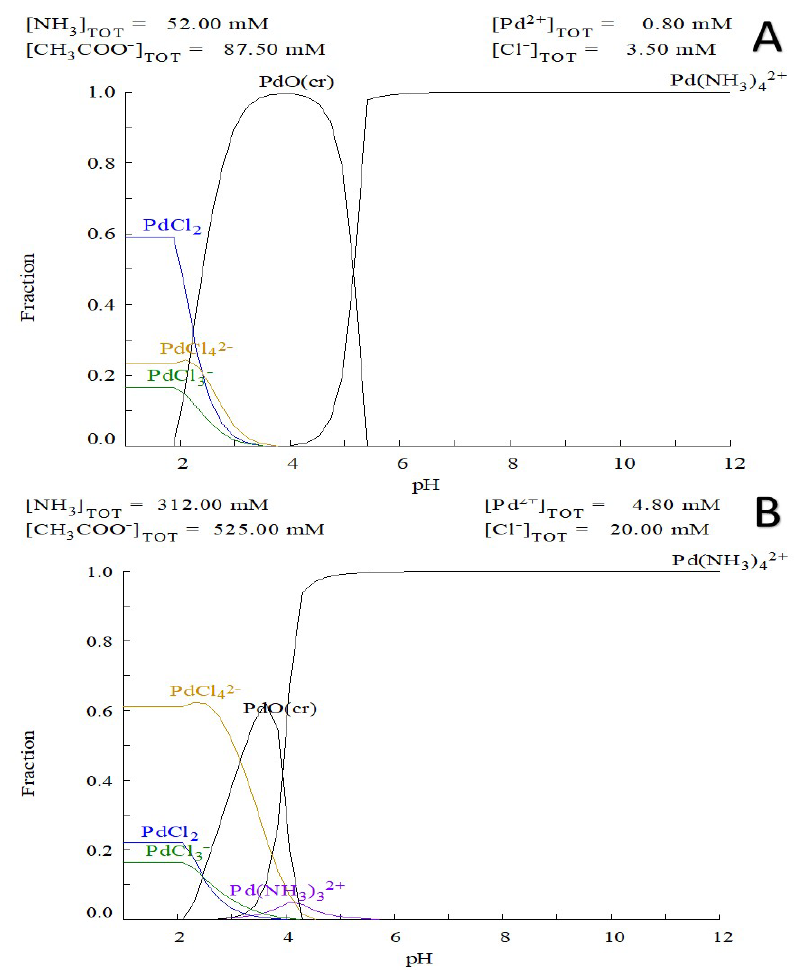
Figure 1. Speciation of palladium ions in the reaction mixture solution of: ( A ) 0.8 mM Pd(II) ions, 52 mM ammonia, 87.5 mM of acetic acid and 3.5mM chloride anion vs pH; ( B ) 4.8 mM Pd(II) ions 312 mM ammonia, 525 mM of acetic acid and 20 mM chloride anion modeling the higher concentration in of cross-linking agent in frozen state (Diagram created by Medusa software).